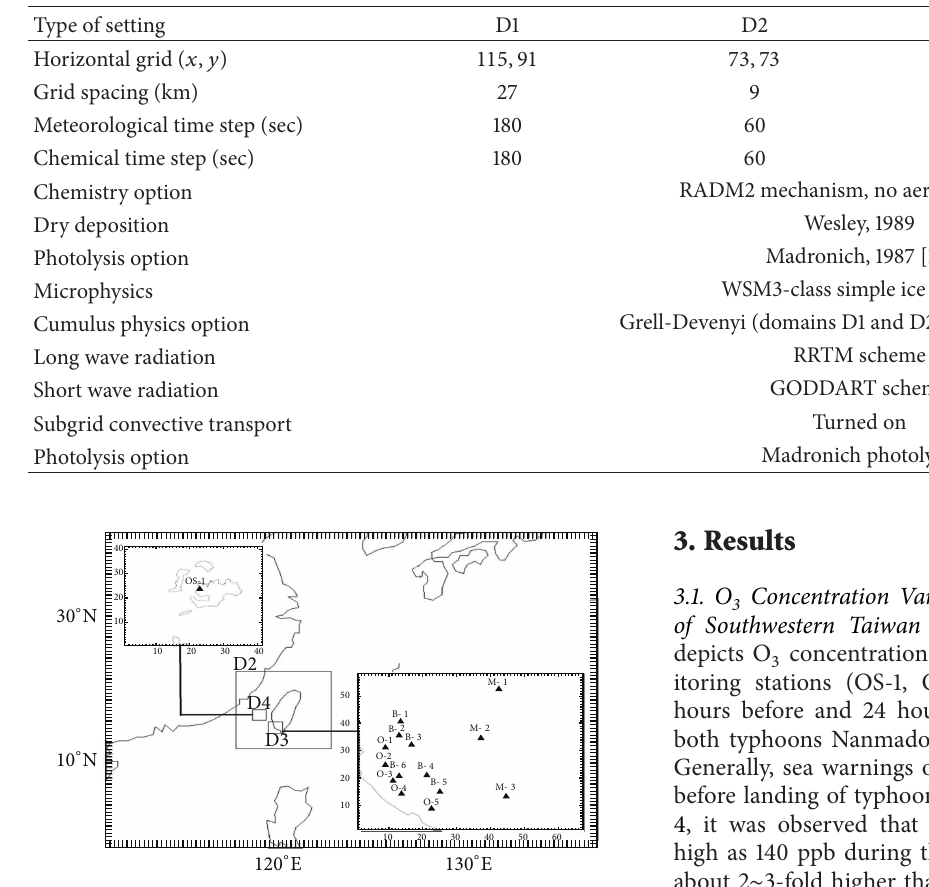
Figure 2: Selected nesting domain setting for WRF-Chem model